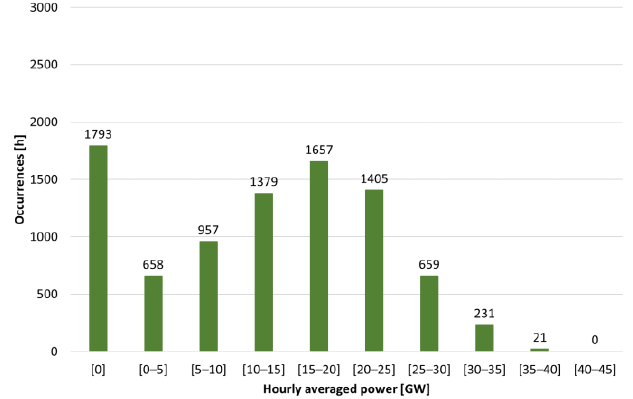
Figure 12. Distribution of hourly averaged power of non-renewable sources over the year in Case 2.